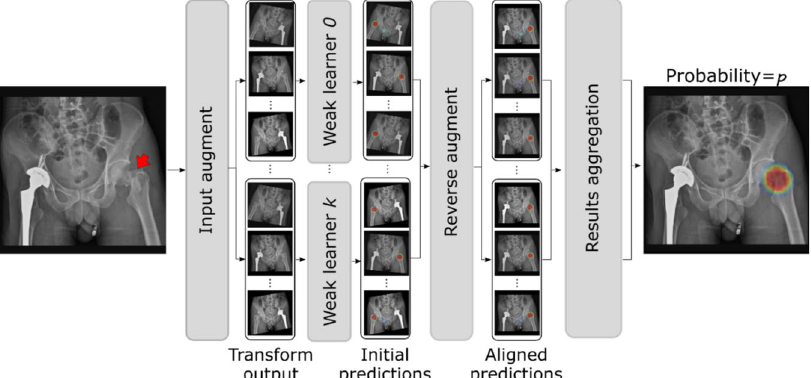
Fig. 5 The Overviw of the ensemble method for inference in testing. During the inference stage, once the image was input, fi ve models with fi ve augmented images each were ensembled to generate the fi nal prediction of the